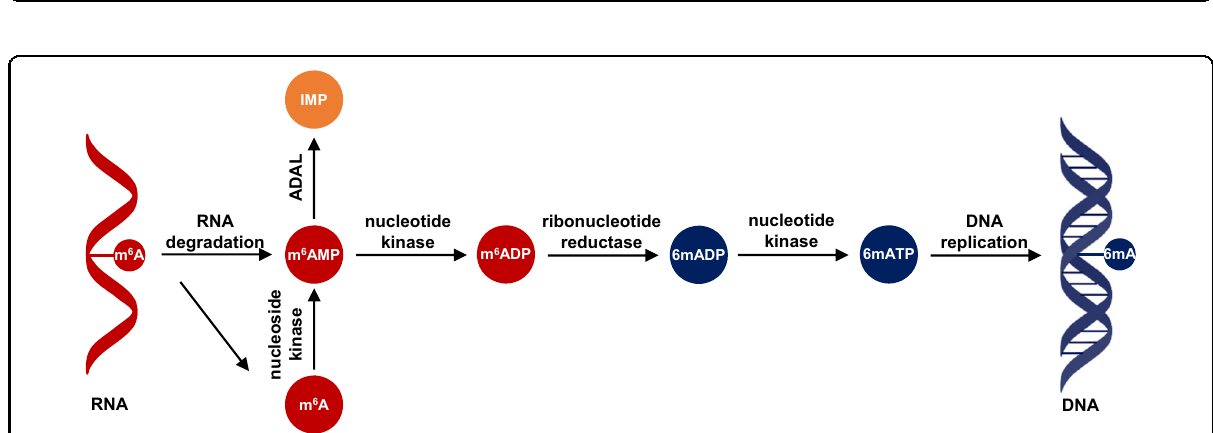
Fig. 6 Cytotoxic stimuli facilitates the release of degraded RNA m 6 A nucleoside to extracellular fl uid and induces the misincorporated DNA 6 mA in neibourghing cells. a , b The release of m 6 A ( a ) or rA ( b ) nucleoside from glioblastoma cells after H 2 O 2 treatment. Glioblastoma cells were treated for 24 h with or without 1 mM H 2 O 2 , and then supernatants were collected and subjected to LC-MS/MS analysis. c Flow diagram of stable isotope labeling for tracing genomic incorporation. d Quanti fi cation of genomic DNA [D 3 ]-6mA in in glioma cell lines, GSCs, and glial cell line. The cells were treated with [D 3 ]-m 6 A at the concentration as indicated. ( ◊ indicated ND (not detected)).